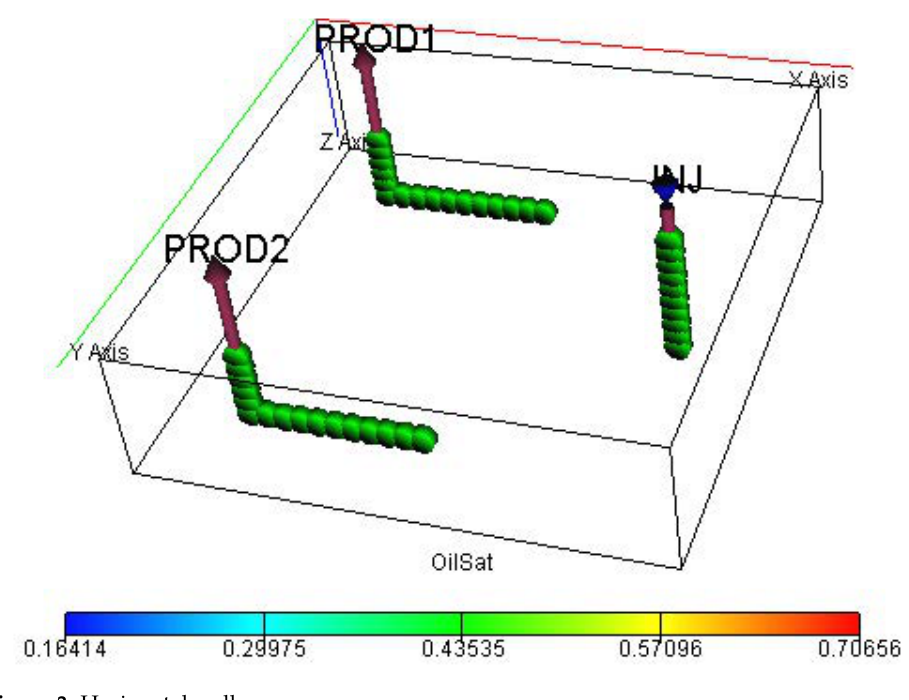
Figure 3. Horizontal wells.